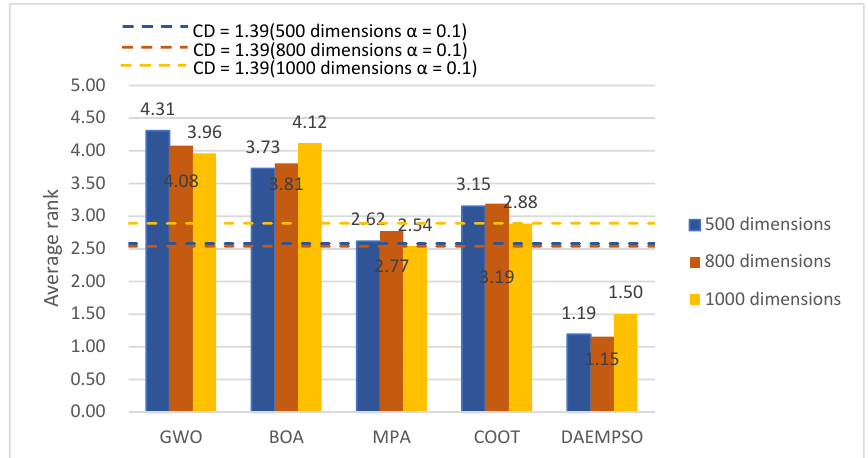
Figure 8. Bonferroni–Dunn’s test for different methods and groups with α = 0.1.